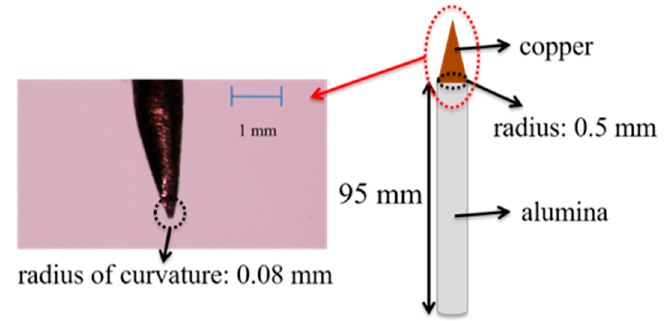
Figure 11. MHA of the imaging experiments.